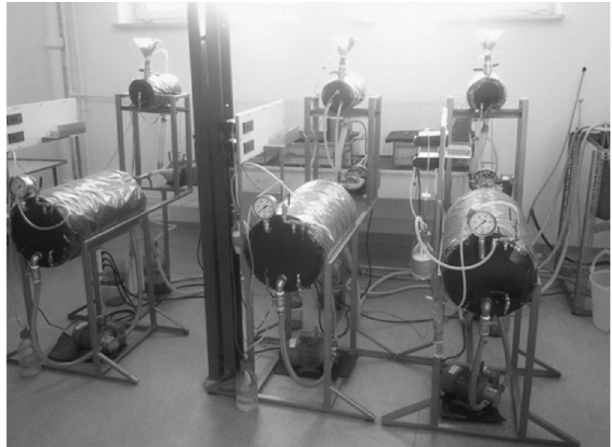
Figure 2. Reactors for carrying out research on the methane fermentation process.